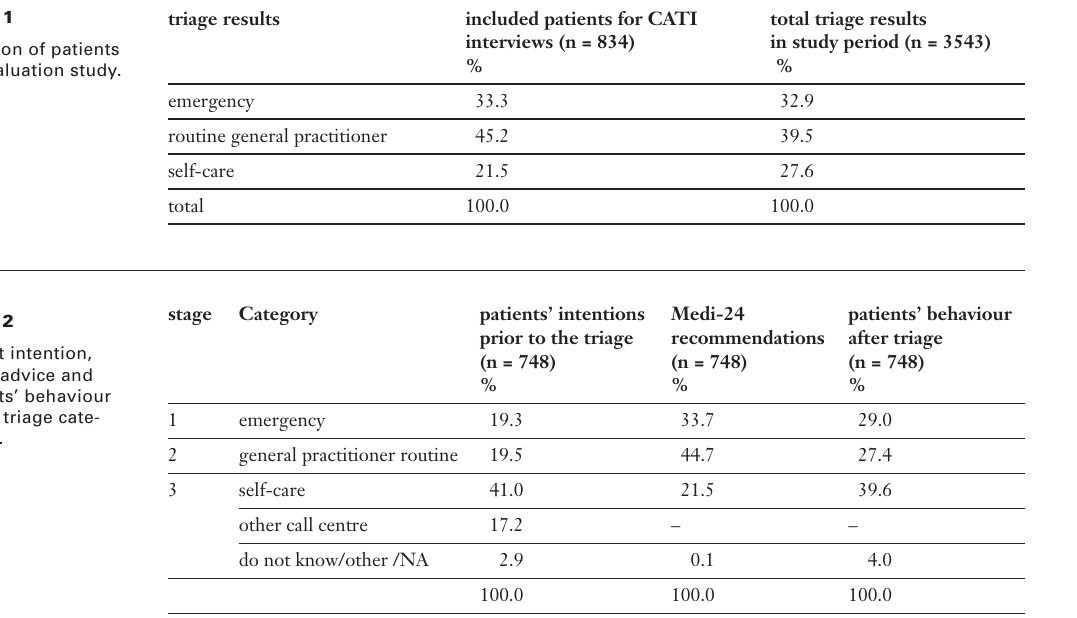
Inclusion of patients for evaluation study.